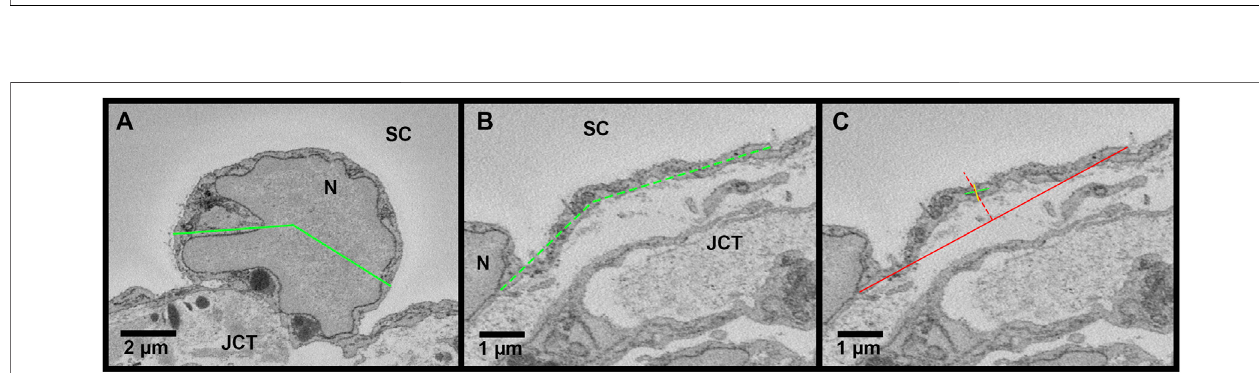
FIGURE2| MethodsformeasuringcellwidthandthicknessinReconstruct. (A) :Thecellwidth( greenline )wasmeasuredinthenuclearareaonthesectionwiththe greatestcross-sectionalareaofthenucleus(N).Toaccountforthecurvatureoftheinnerwall,asegmentedlinewasused,ifnecessary. (B) :Thecellwidthwasmeasured in the non-nuclear regions ( dashed green line ). (C) : The cell thickness was measured on the section with the greatest cross-sectional area of the nucleus to determine thickness in the nuclear region and on sections where the nucleus and giant vacuoles were not present (shown) to determine the thickness in non-nuclear thickness.First, a solidred line wasdrawnconnectingthe2 cellborders and a dotted redline wasdrawn perpendicular at thehalfway point. Then, a solidgreenline was drawnthrough theaxis ofthe cell, intersecting the dotted red line . Finally, a solid yellow line wasdrawn perpendicular to thegreen axis lineto measure the cell thickness, crossing the intersection of the solid green axis line and the dotted red line . JCT = juxtacanalicular connective tissue; SC = Schlemm ’ s canal.